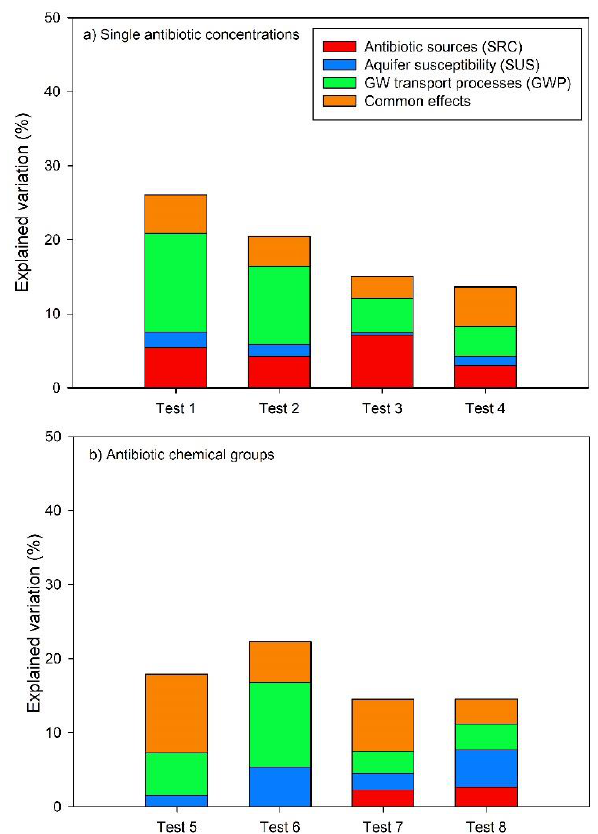
Figure 5. Plot of the VP tests conducted under distinct approaches, combining how the antibiotic concentration is treated: ( a ) single antibiotic (tests# 1–4) vs. ( b ) antibiotic group (tests# 5–8), the radius of the buffer zone (tests# 1, 3, 5, 7: 100 m; tests# 2, 4, 6, 8: 500 m), and the use of raw hydrochemical data (tests# 1, 2, 5, 6) or PCA-VF (tests# 3, 4, 7, 8; see Figure 2 and Table 3 for details).